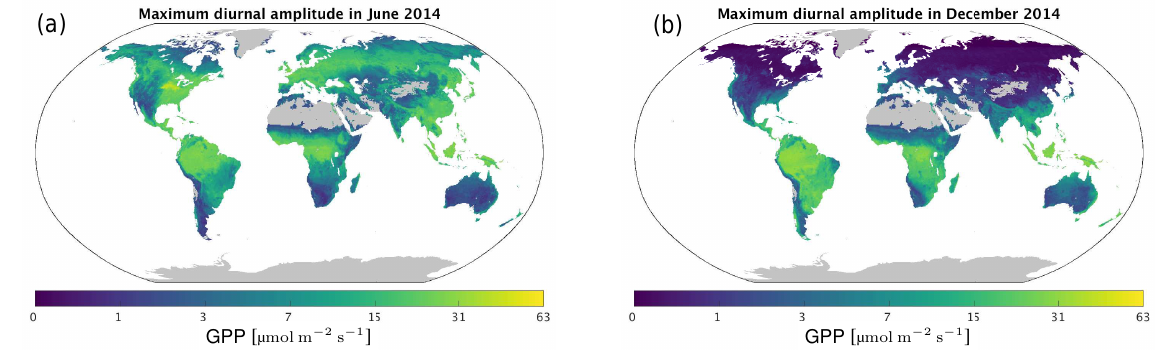
Figure 13. Maximum diurnal amplitudes of GPP within a month are shown for June 2014 (a) and December 2014 (b) . Differences between summer and winter for both the Northern Hemisphere and the Southern Hemisphere as well as (almost) constant productivity in tropical regions can be observed from both maps. Note the logarithmic color scale.